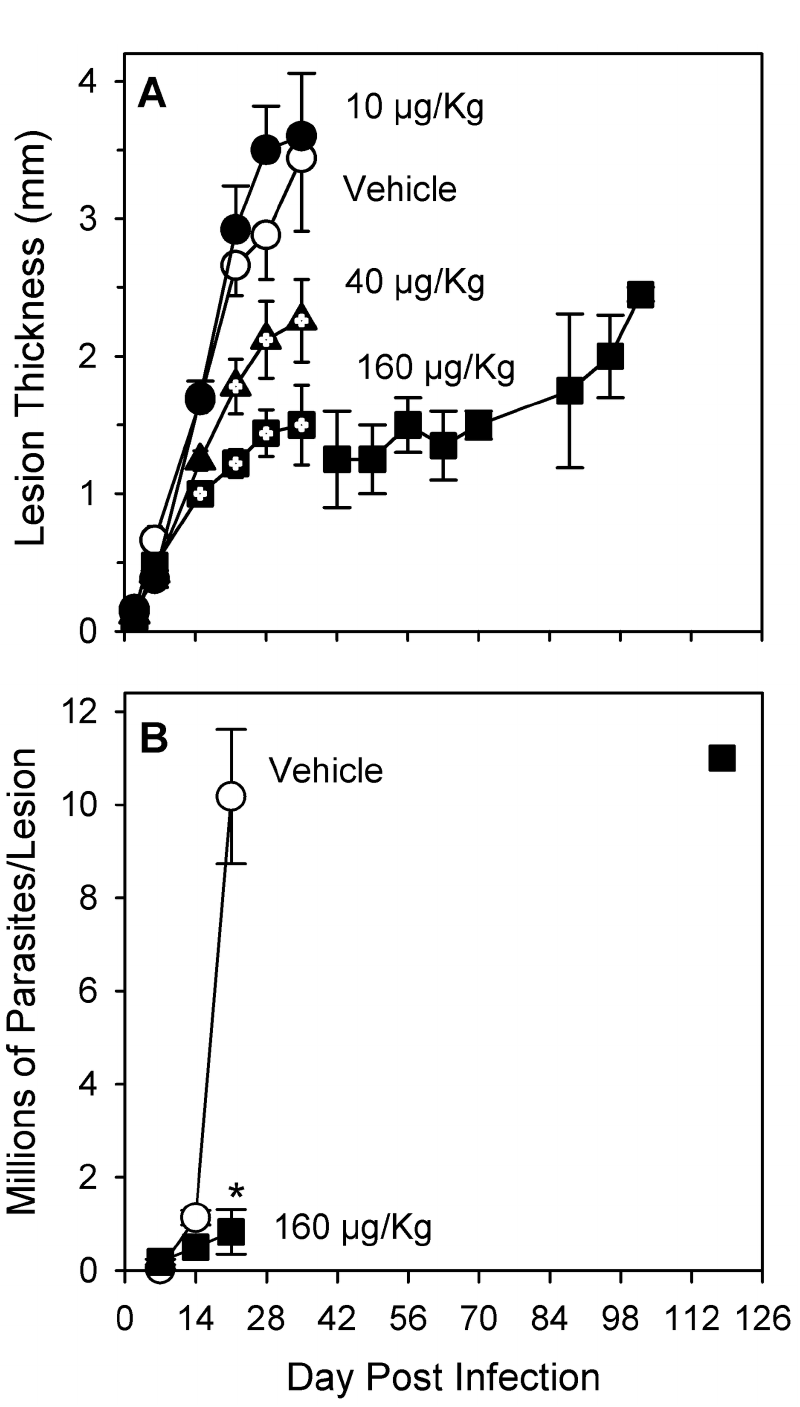
Figure 1. TCDD reduces parasite burdens and slows the progression of cutaneous leishmaniasis in BALB/c mice. Female BALB/c mice were treated with peanut oil (vehicle) or TCDD at various doses (per os) one day prior to infection with one million stationary phase L. major promastigotes in one rear footpad. Data are shown for 3-5 mice per treatment group on days 2-35 and are representative of three independent experiments. Data for two mice from one experiment are shown after day 35. (A) Lesion size is shown as mean ± SEM. Symbols with internal plus marks (+) indicate a statistically significant difference from vehicle-treated mice on that day (p < 0.05). (B) Parasite burdens in infected feet are shown (mean ± SEM) for mice euthanized on the days indicated: three mice per group up to day 35; after day 35, two mice were pooled (n = 1) . *Indicates a statistically significant difference from vehicle-treated mice on that day (p < 0.02). doi: 10.1371/journal.pone.0076259.g001 PLOS ONE |